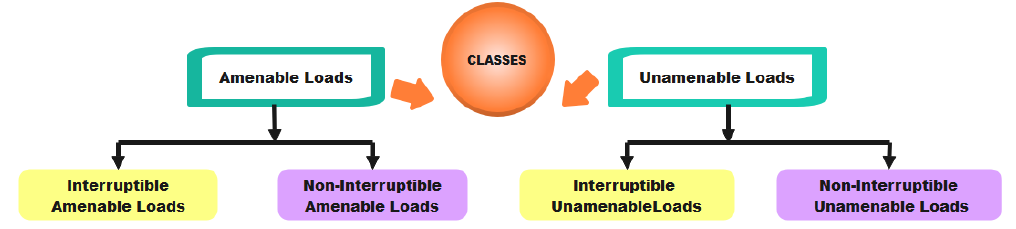
Figure 2. Classification of KCET